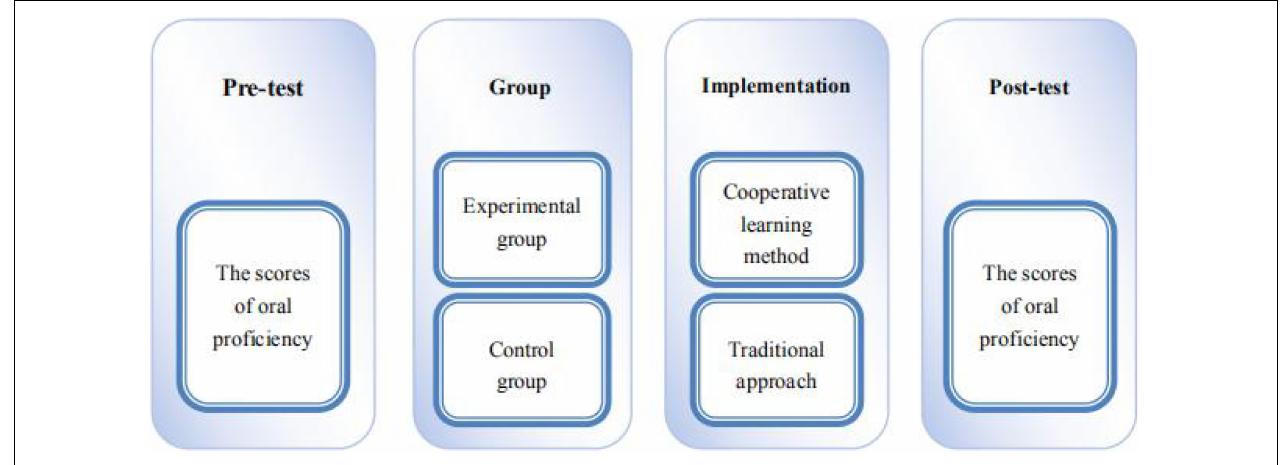
FIGURE 1 | Research design of the